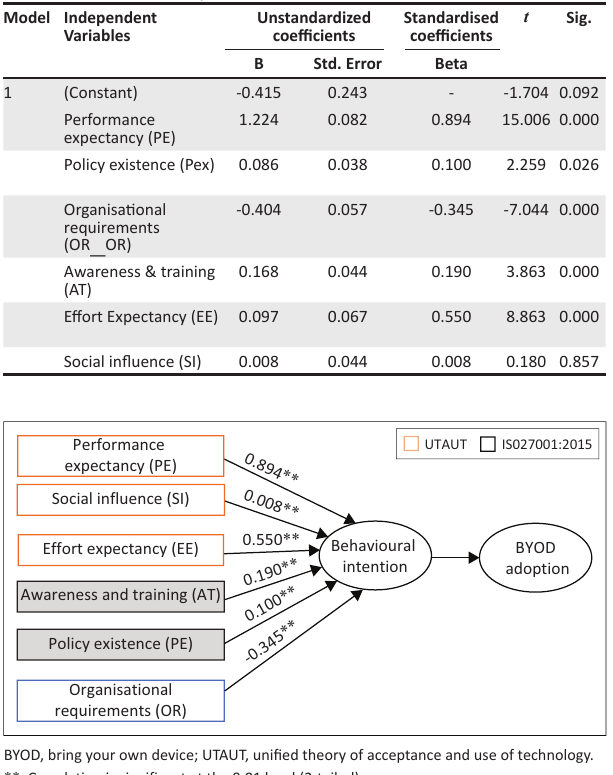
FIGURE 3: Final model of unified theory of acceptance and use of technology + International Organization for Standardisation/International Electrotechnical